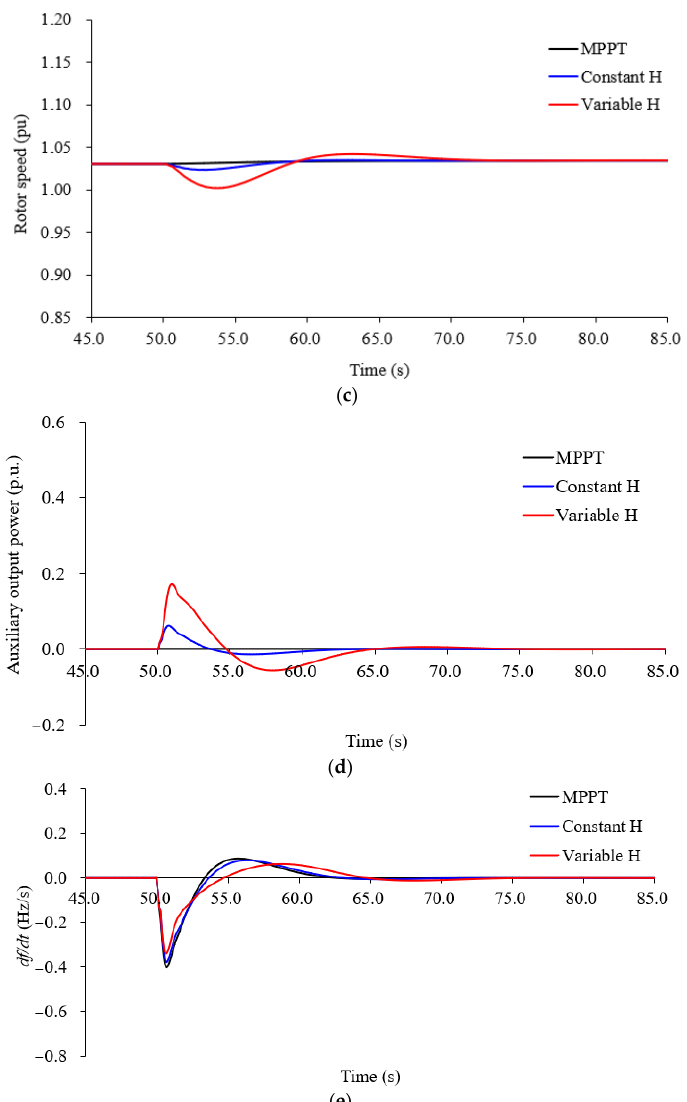
Figure 7. Results for Case 1: ( a ) system frequency; ( b ) output power; ( c ) rotor speed; ( d ) auxiliary active power; ( e ) rate of change of frequency.